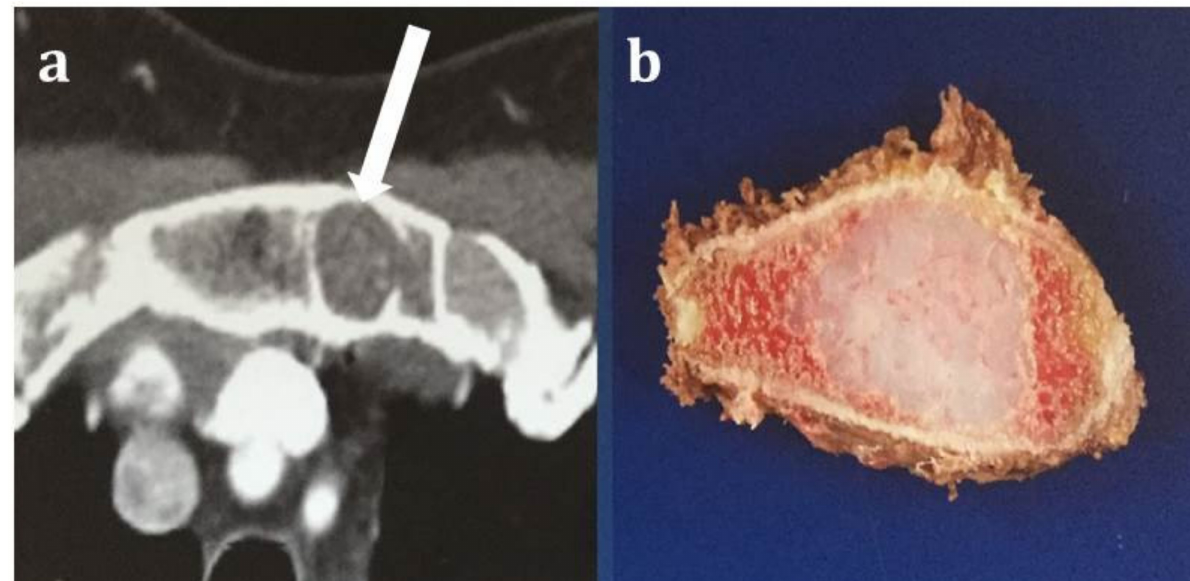
Figure 2. A 49-year-old female patient with grade 2 chondrosarcoma (long white arrow) of the sternum. Contrast-enhancement axial CT with soft tissue window ( a ) shows a lytic lesion with a few punctate calcifications. Gross pathology specimen resection of the sternum ( b ) showing a white-yellow tumor surrounded by bone marrow. Based on imaging, it is not possible to differentiate the lesion from an enchondroma. Enchondromas in the sternum are extremely rare and a solid lesion in the sternum should raise concerns for malignancy until proven otherwise.